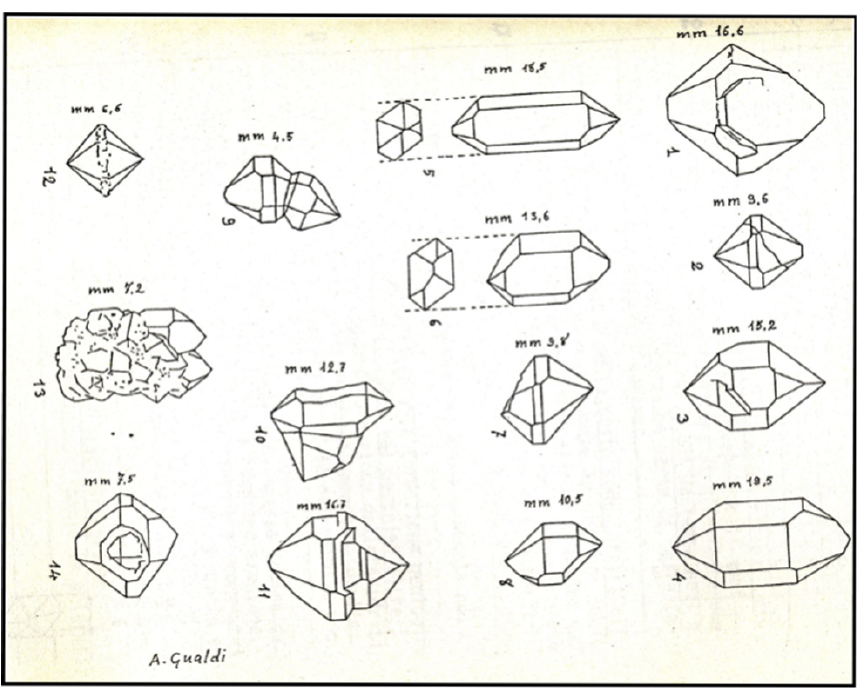
Figure 6. Morphological table of Burano Formation quartz (drawn by Alberto Gualdi). The minimum values of length and width of 355 crystals from the Burano Formation were measured with a micrometer; the values are shown on the diagram of Figure 8 (black spots). Since the minimum length/width ratio (L/W) is directly proportional to the length of the prism, its values can be used to describe the type of habitus. The L/W ratio is a very important parameter for gem cutters who use it frequently to determine the correct patterns for cutting gemstones and also create new gem designs. The values of the L/W ratio slightly higher than 1 correspond to type III, i.e. a habitus without a prism, while the values of the L/W ratio of about 2.5 correspond to type VI, with a fairly well developed prism